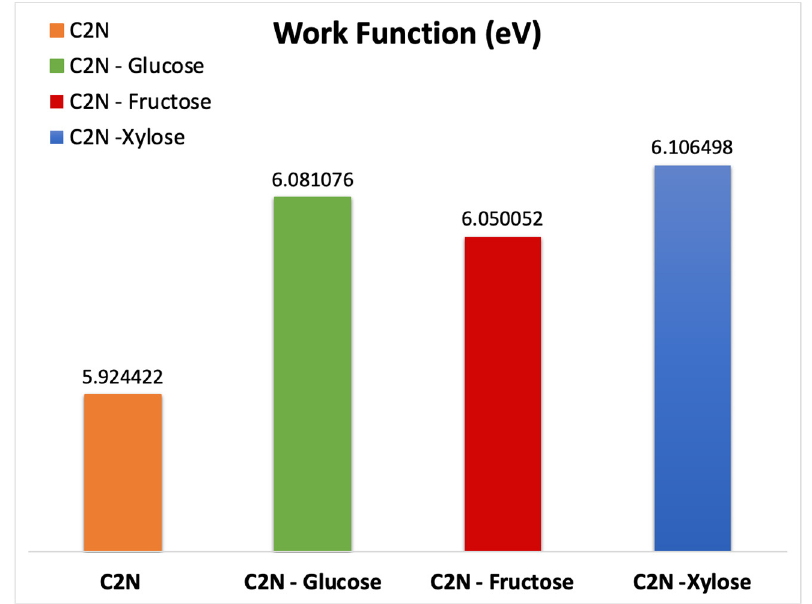
Figure 6. Work function of: C 2 N FET; C 2 N FET with the presence of glucose molecule; C 2 N FET with the presence of fructose molecule; and C 2 N FET with the presence of xylose molecule.